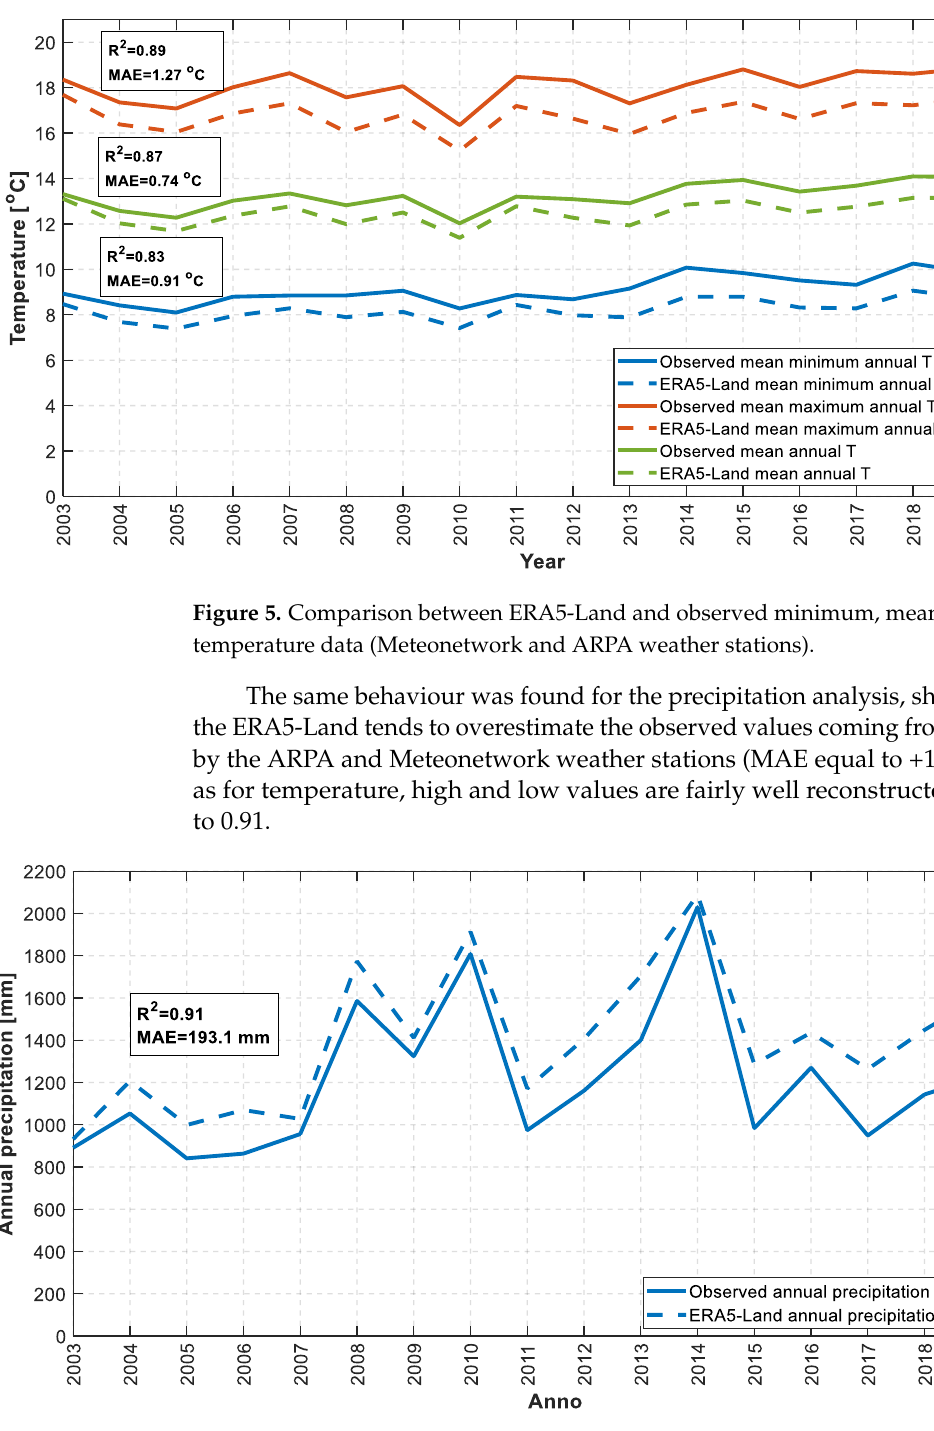
Figure 6. Comparison between ERA5-Land and observed annual precipitation data (Meteonetwork and ARPA weather stations).